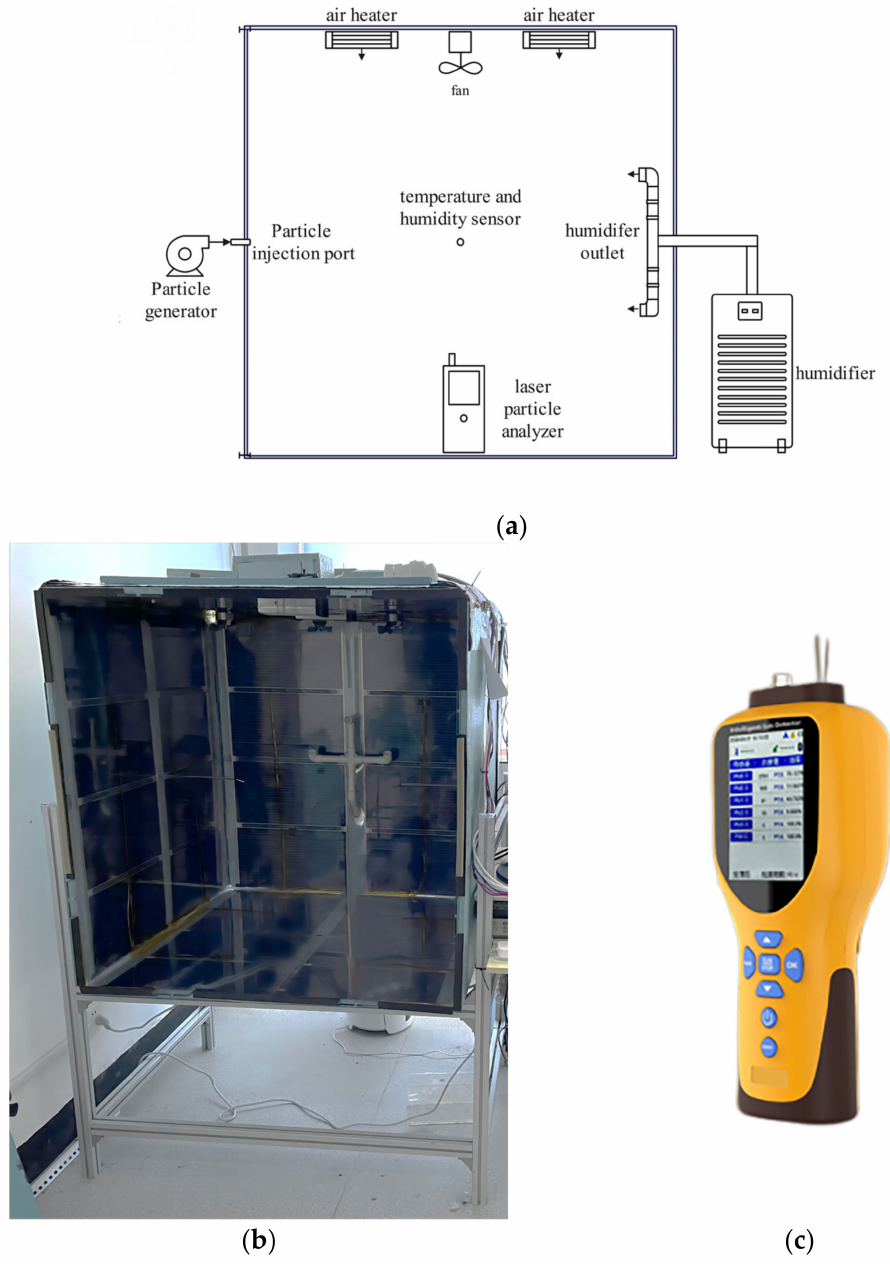
Figure 2. ( a ) Schematic diagram of experimental chamber. ( b ) Effect diagram of the experimental chamber. ( c ) Laser particle analyzer. Table 1. Key parameters of the measuring